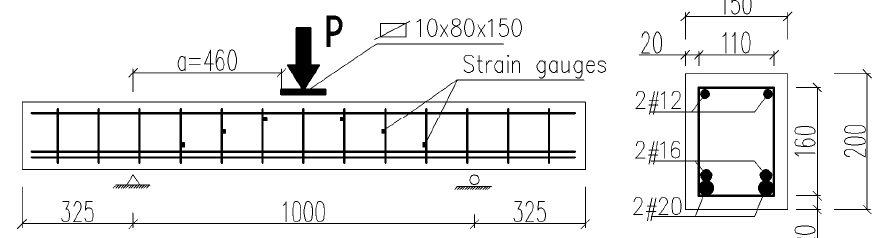
Figure 5. Specification of tested beams. Table 3. Description of the test elements.